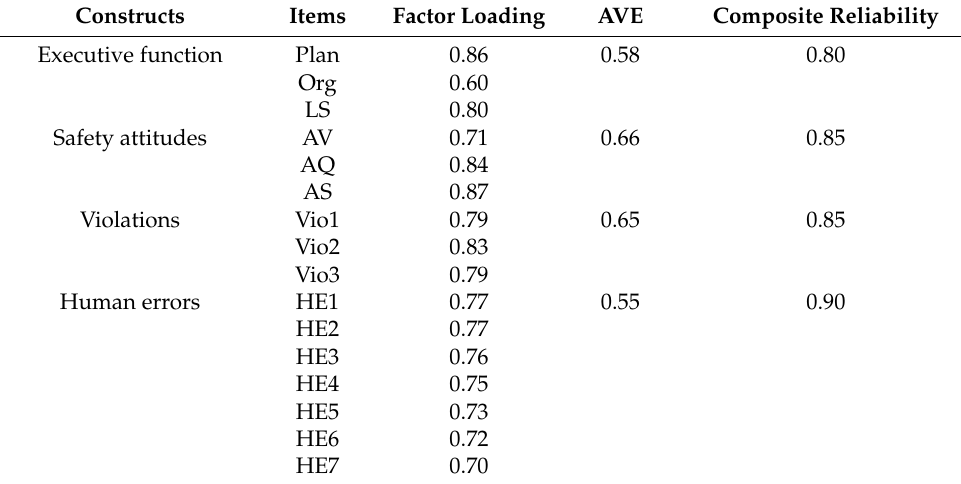
Table 2. Factor loading, AVE and composite reliability of the constructs.